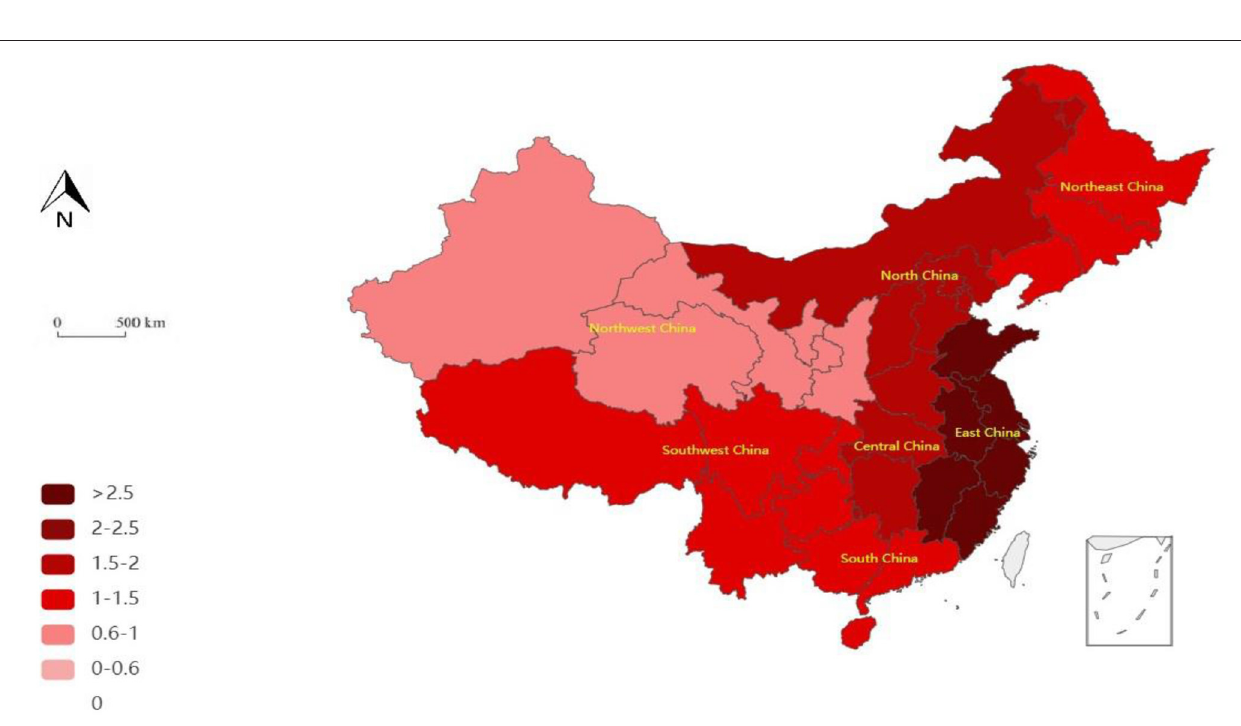
Frontiers in Public Health |